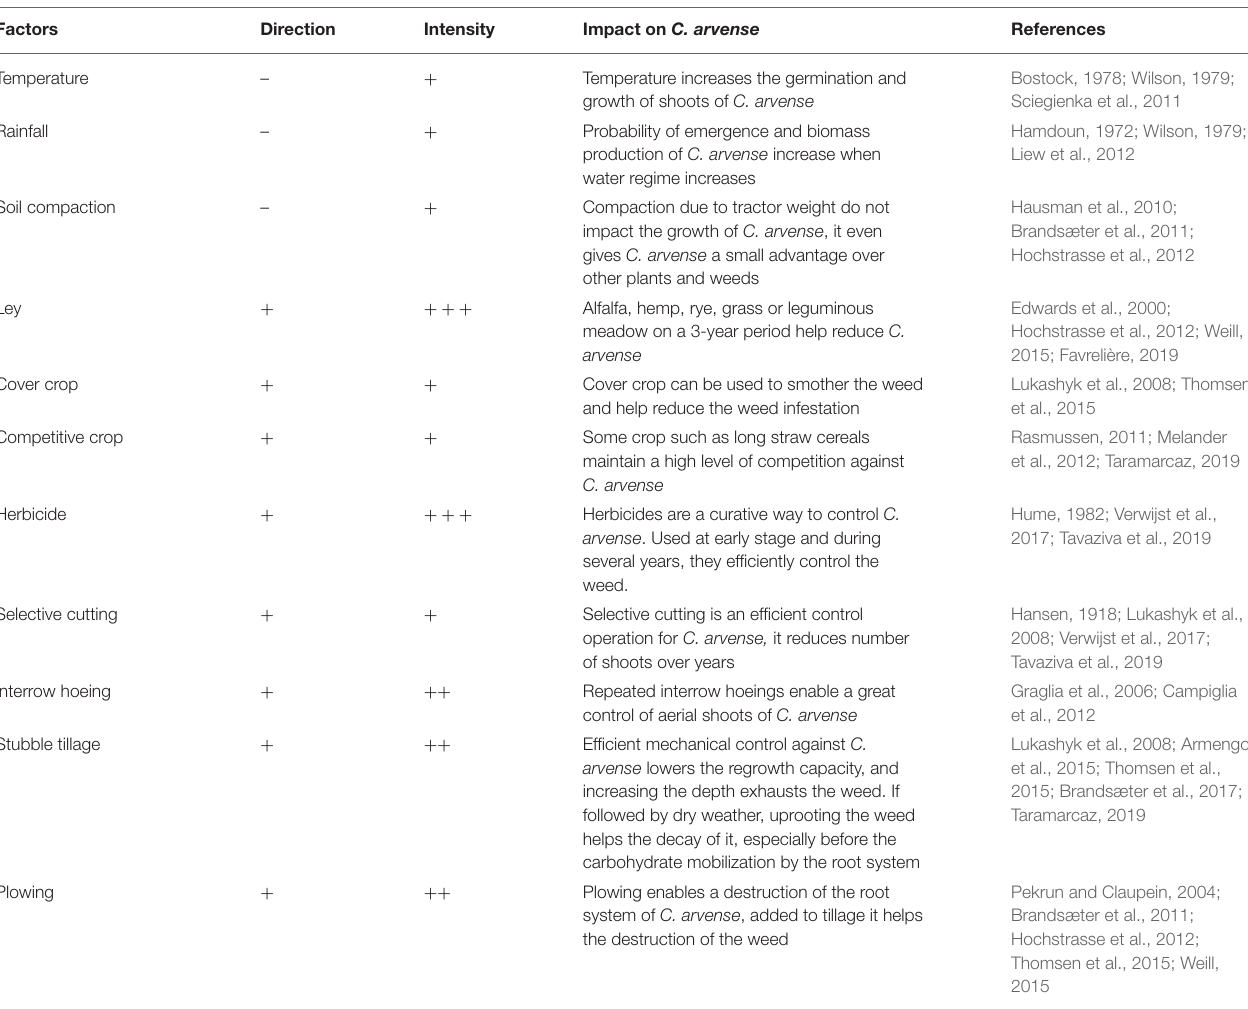
TABLE 1 | Literature on the effects of climate, soil and cropping practices on the growth of Cirsium arvense